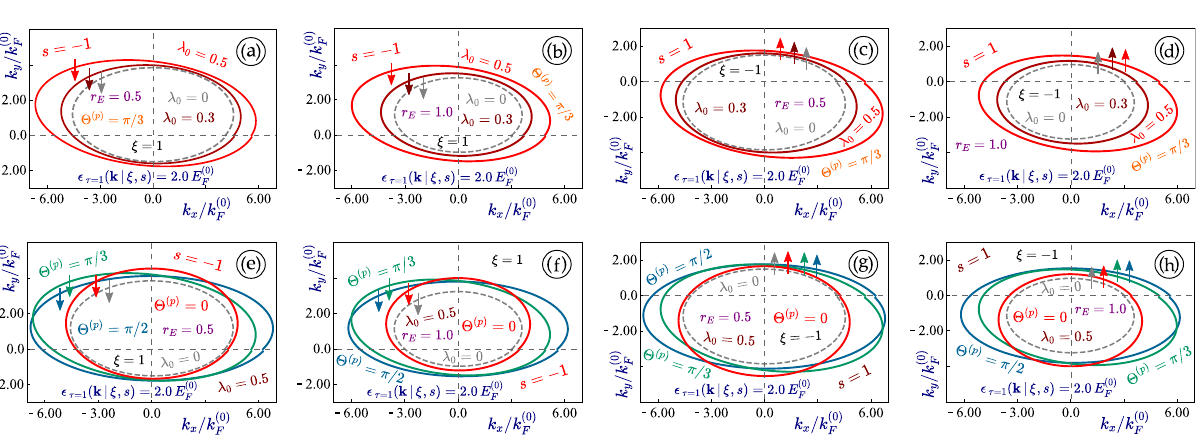
( L ) (cid:31) k 1, s ) for the case of linearly polarized ξ Figure 5. (Color online) Energy dispersions ε 0 , 1 ( τ | = − =± 0 ) and the same irradiation applied to a 1T ′ -MoS 2 lattice. The dispersions for non-irradiated materials ( (cid:31) 0 = lattice parameters are also presented as dashed and gray curves for comparison. Upward and downward spin 1 are denoted by green and red arrows, respectively. The linear-polarization angle 1 and s states with s = − = + 0.5 are chosen for all plots. � ( p ) π/ 3 of a dressing field and the electron-photon coupling parameter (cid:31) 0 = = Three upper panels ( a )-( c ) show the initially asymmetric k y -dependence of the electron band structure, while the lower ones ( d )-( f ) demonstrate its k x -dependence. Both rows of panels are related to a specific value of 0.5 [( a ), ( d )], 1.0 [semi-metallic; ( b ), ( e )] and 1.5 [( c ), ( f )], as labeled. Here, external electrostatic field r E = 1 value of the valley index ( K ξ ′ -valley) was selected for all plots. = −